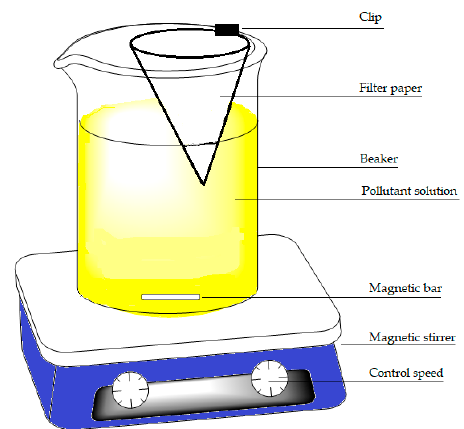
Figure 1. Illustration of the one-pot method for in situ kinetic